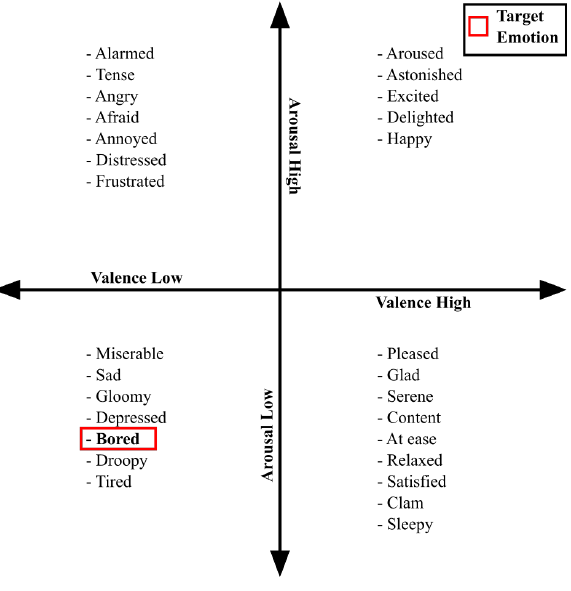
Figure 1. Circumplex model